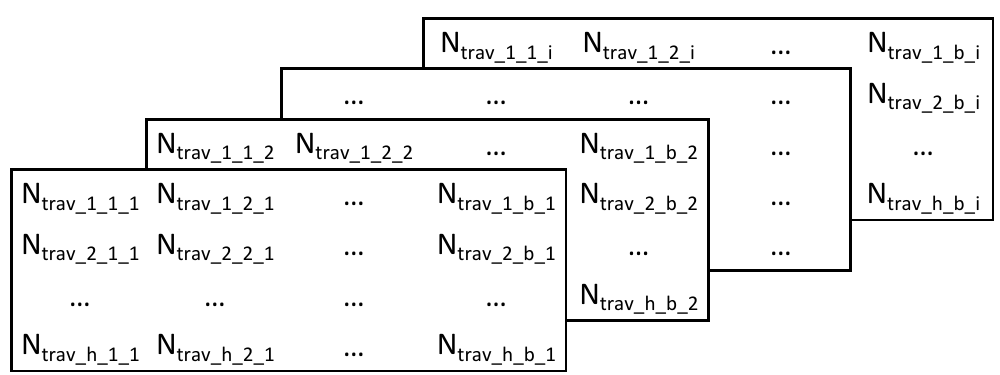
Figure 5. Matrix N